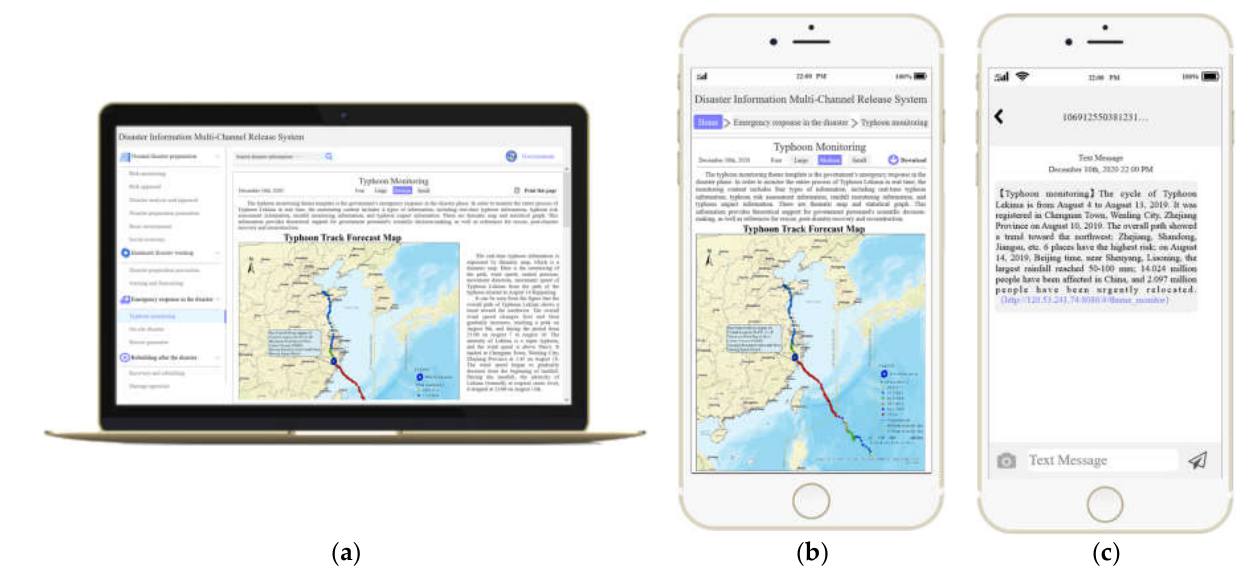
Figure 10. Government interface map. ( a ) Web; ( b ) APP; ( c ) SMS.